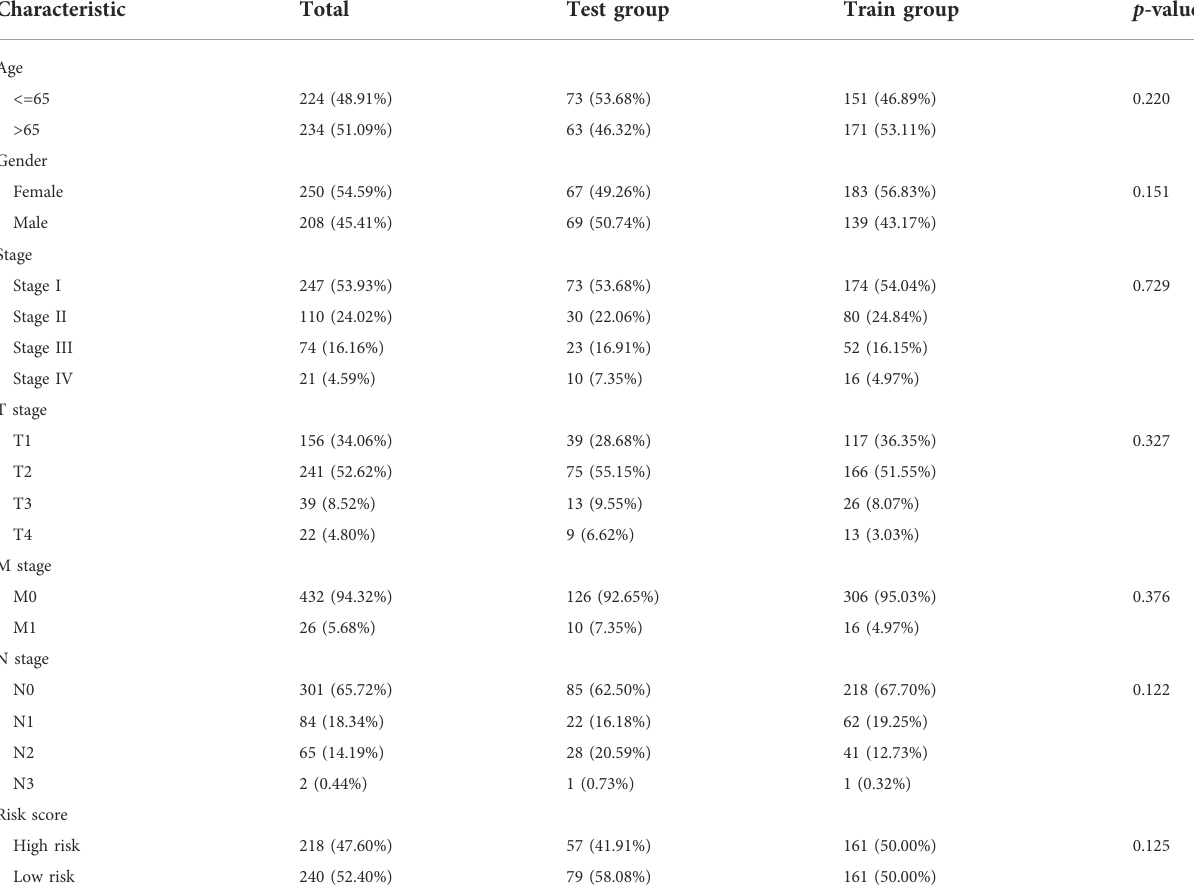
TABLE 1 The clinical characteristic of TCGA testing set and training